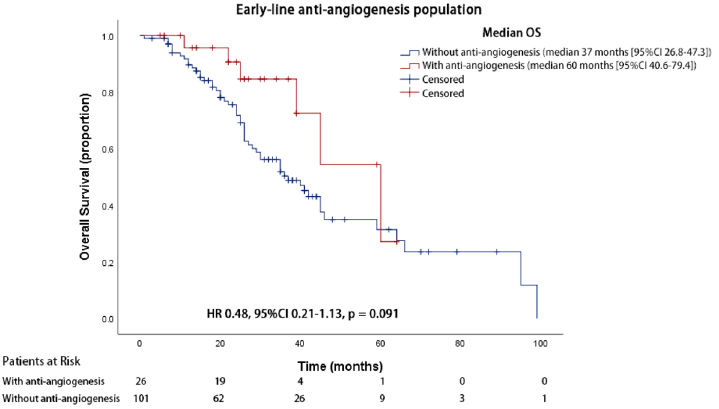
Figure 5. Kaplan–Meier survival curve of overall survival for patients treated with 1st and 2nd line anti- angiogenesis or without anti-angiogenesis therapy.